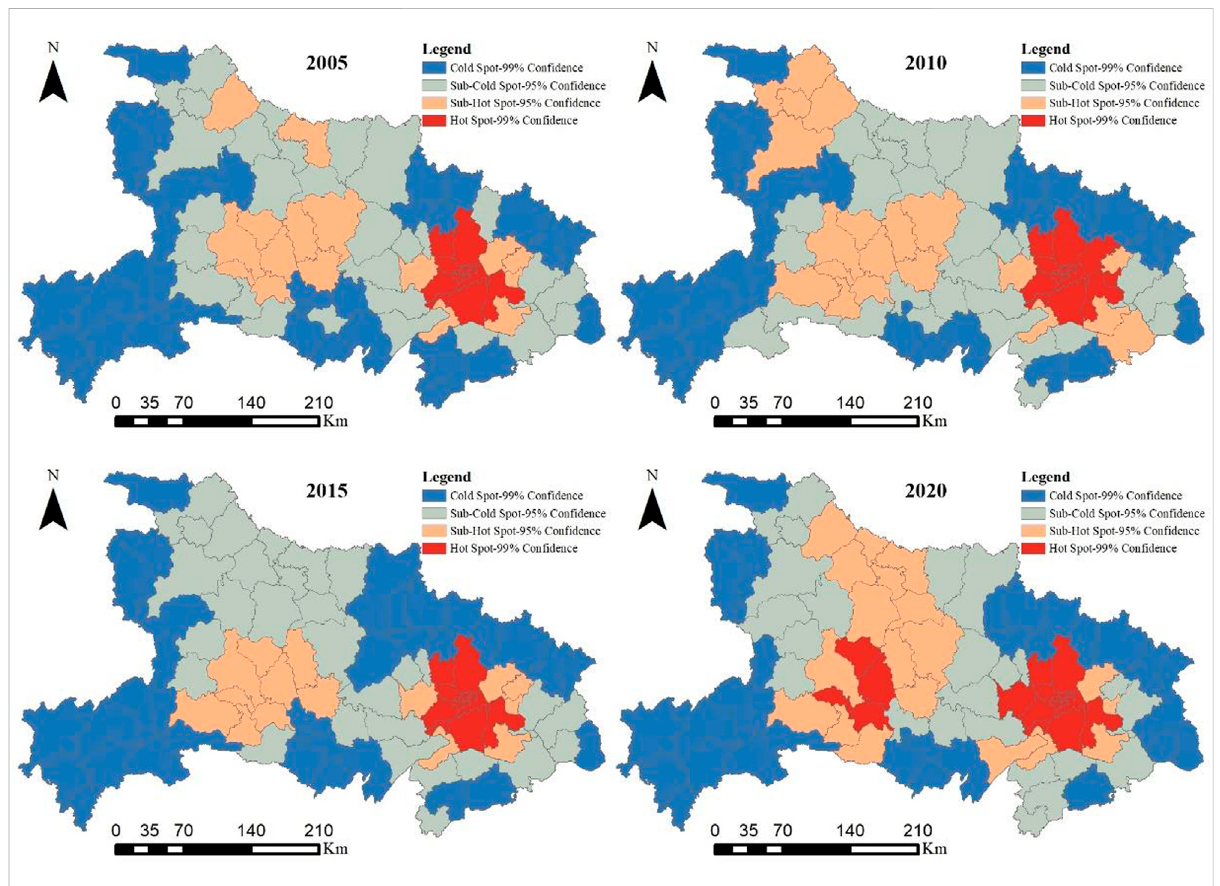
FIGURE 8 Distribution of county economy hot spots with different con fi dence levels from 2000 to